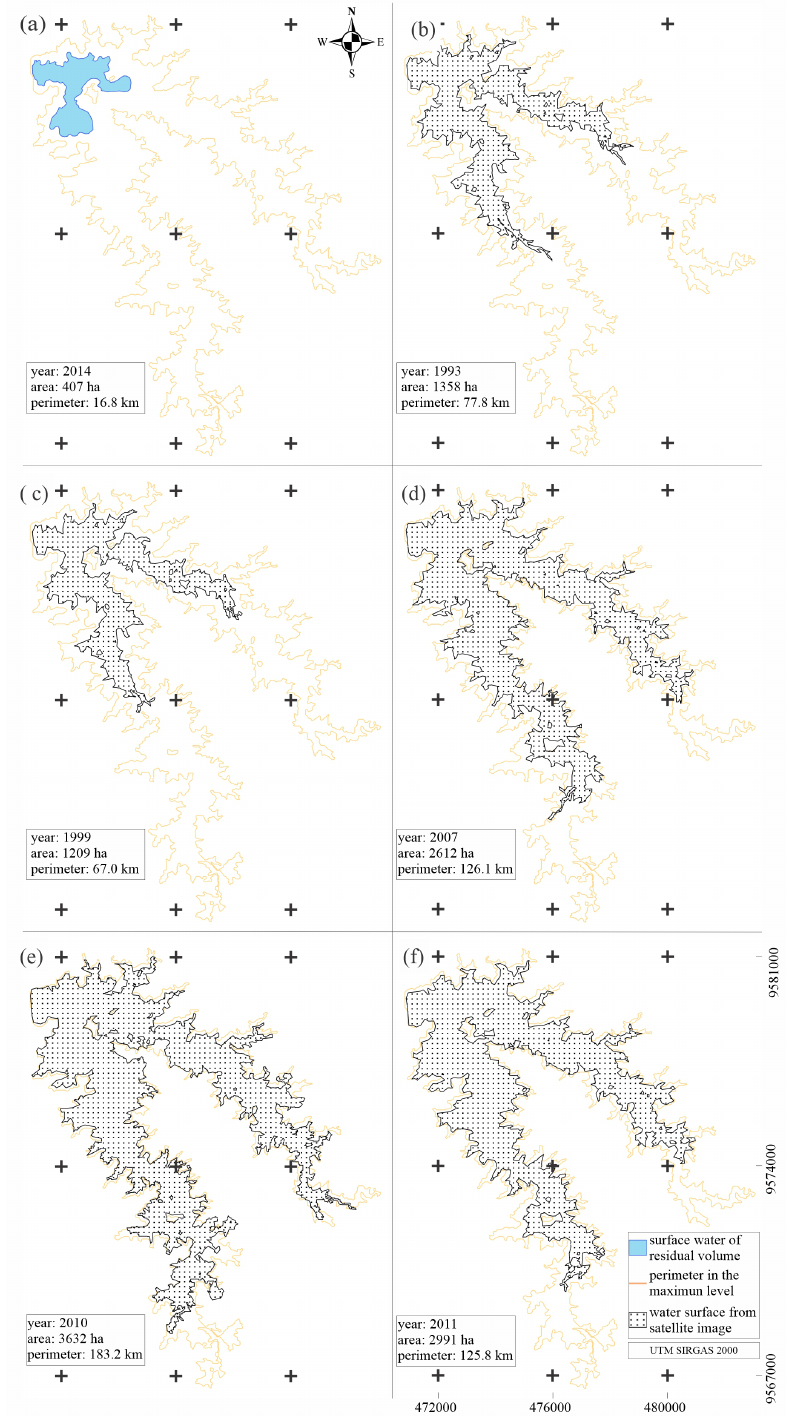
Figure 5. In ( a ), the figure compare the surface water of residual volume with the area/perimeter in the maximum water storage capacity. From ( b – f ) the figures show the flooded water surface of the Pentecoste reservoir obtained from Landsat 5 TM images in relation to the maximum water storage